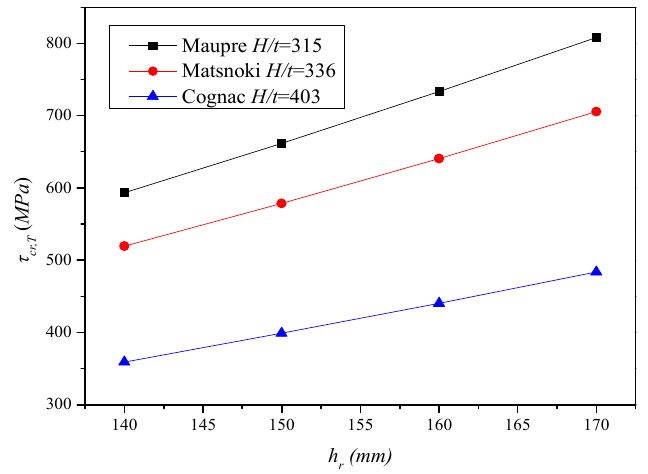
Figure 10. Global elastic shear buckling strength of PCCSW in theory τ cr,T versus corrugation height h r ( R = 110 m).